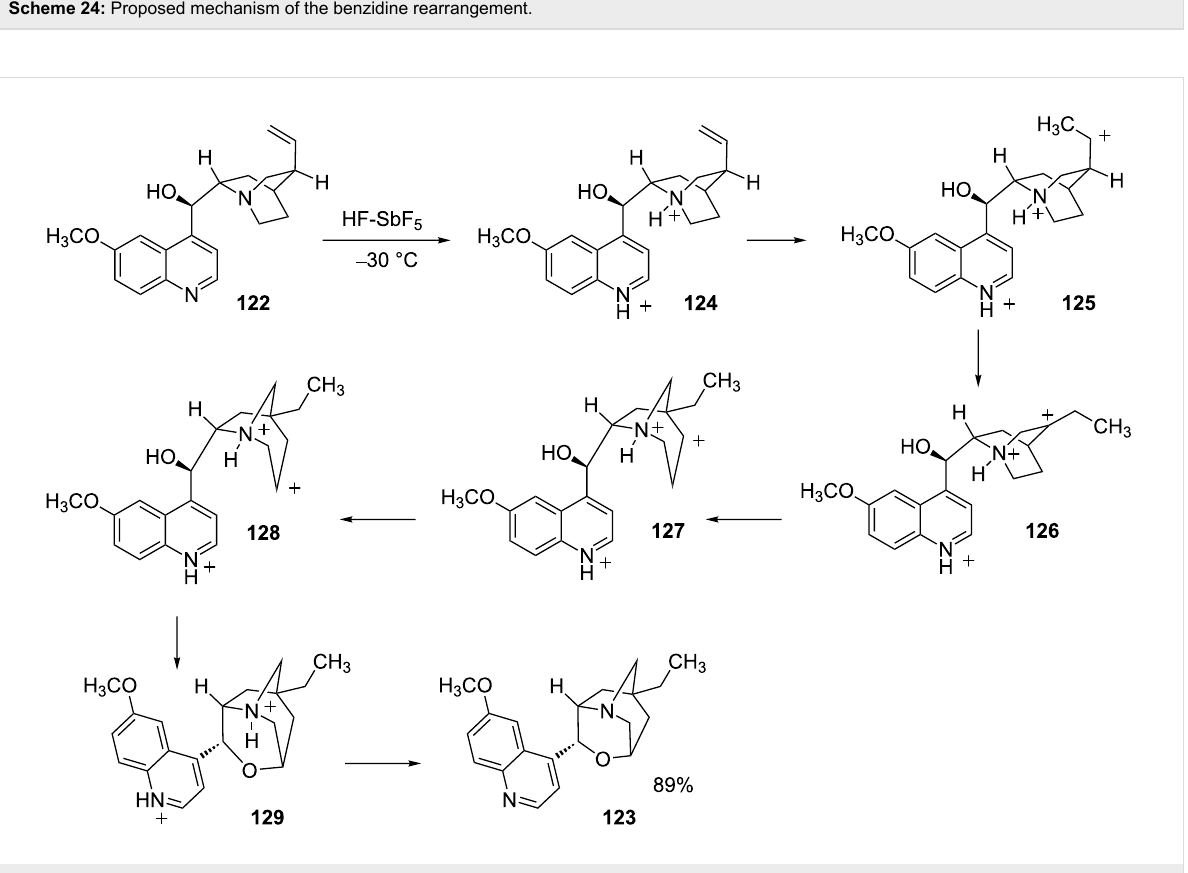
Scheme 25: Superacid-promoted reaction of quinine ( 122